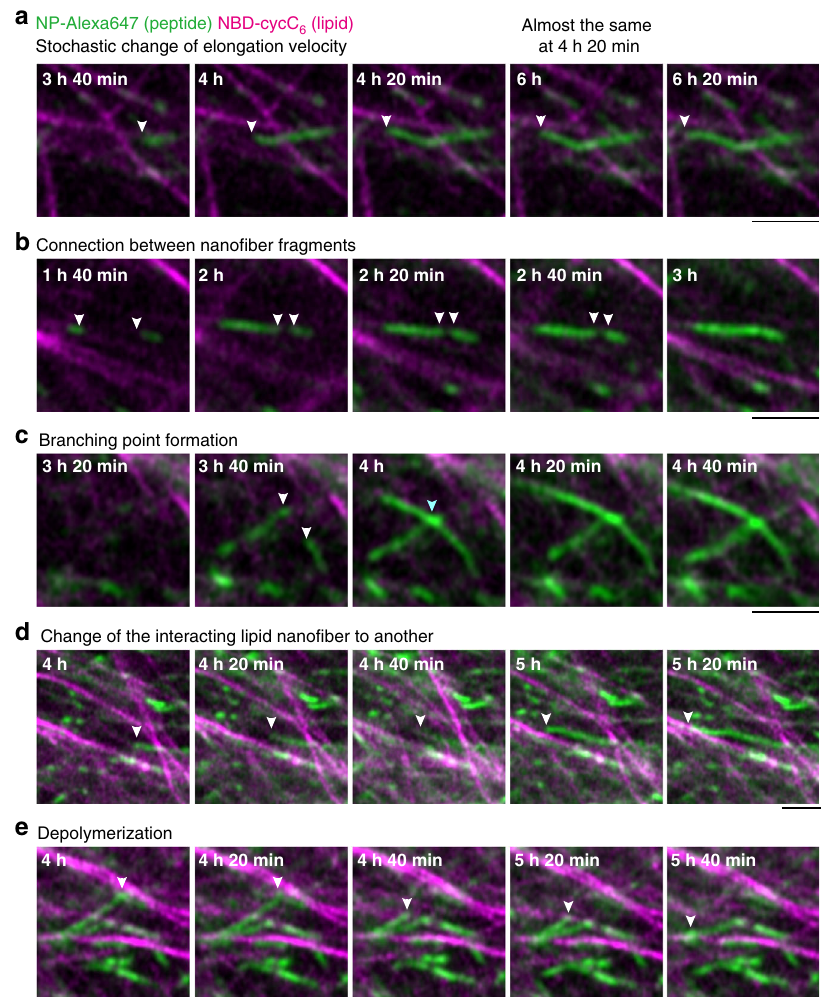
Fig. 7 Unique elongation/collapse behaviors of the peptide-type nano fi bers during the oxime-exchange reaction. a Stochastic change of elongation velocity, ( b ) connection between nano fi ber fragments, ( c ) formation of a branching nano fi ber, ( d ) change of interacting lipid-type nano fi ber to another, and ( e ) depolymerization. White and sky blue arrows show the tips of peptide-type nano fi bers and a crosslinking point, respectively. The detailed location of each magni fi ed image is shown in Supplementary Fig. 39. Scale bar: 2 µ m. Green: NP-Alexa647 , magenta: NBD-cycC 6 . Condition: [ Ald-F(F)F ] = 17.3